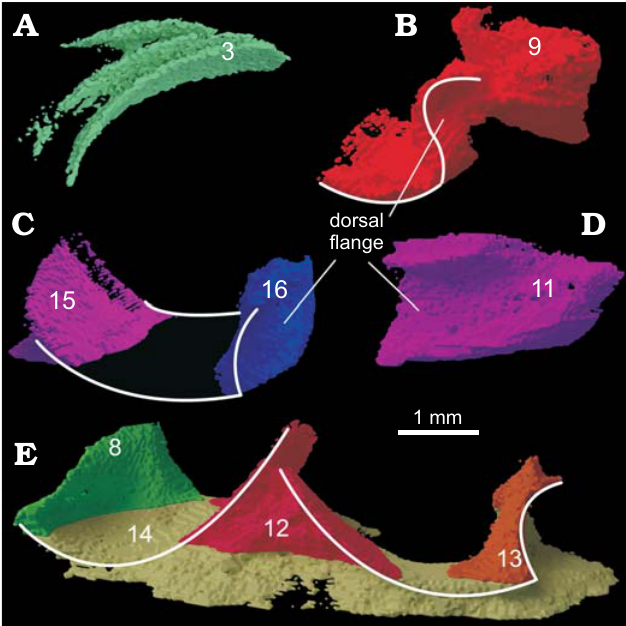
Fig. 5. Overview of the other objects found in the sample. A . Object 3 could not be identified with certainty, but is likely part of a sclerite from the flank. B . Sclerite 9 might be from the dorsal articulation. C . Objects 15 and 16 might belong to the same, incomplete sclerite. D . Sclerite 11 preserves only the dorsal flange. E . Objects 8, 12, 13, and 14 might actually be parts of two sclerites as indicated by the white